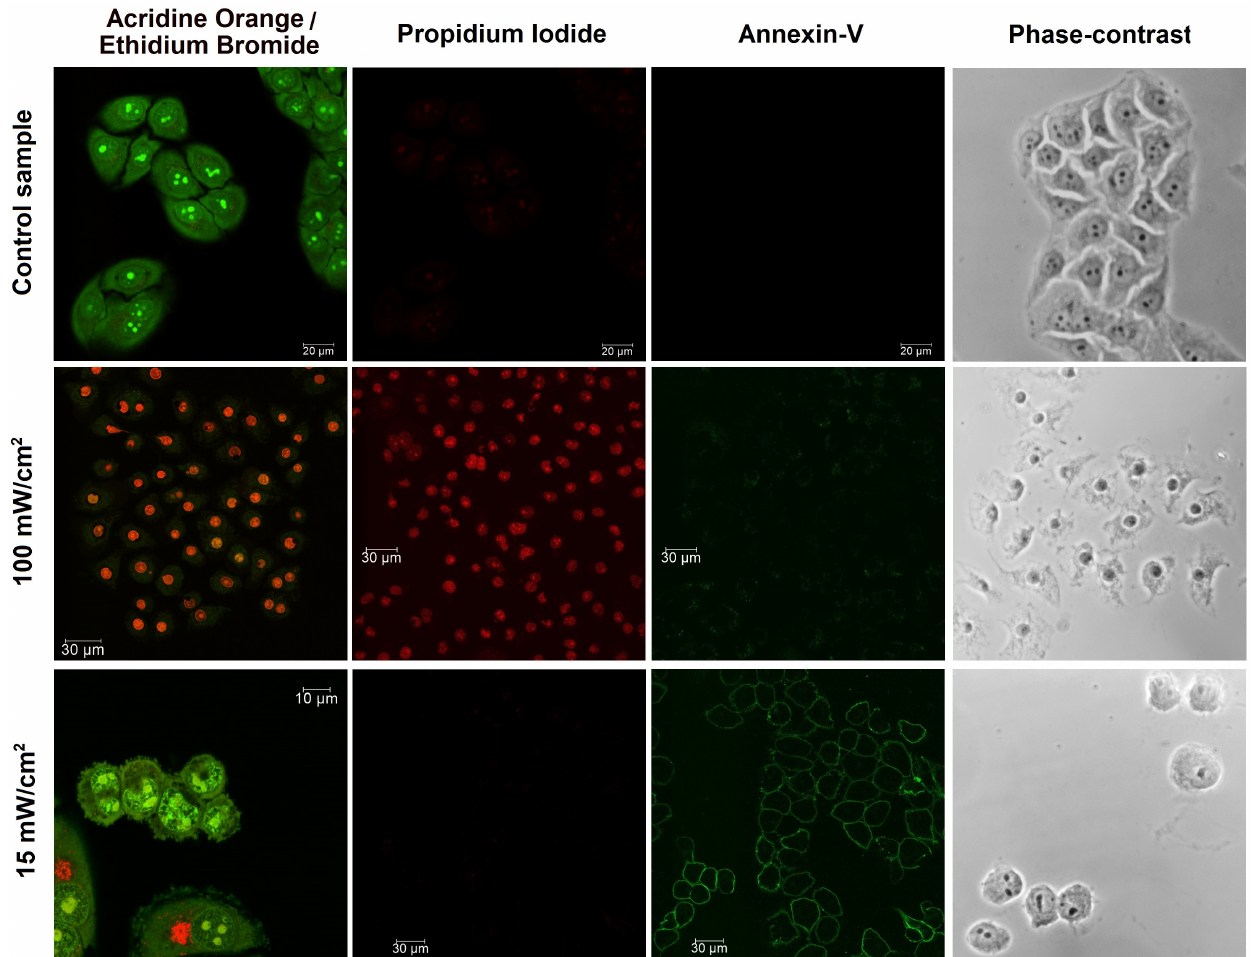
Figure 2. Examples of fluorescence and phase-contrast images of apoptotic and necrotic HeLa cells obtained after PDTr at different